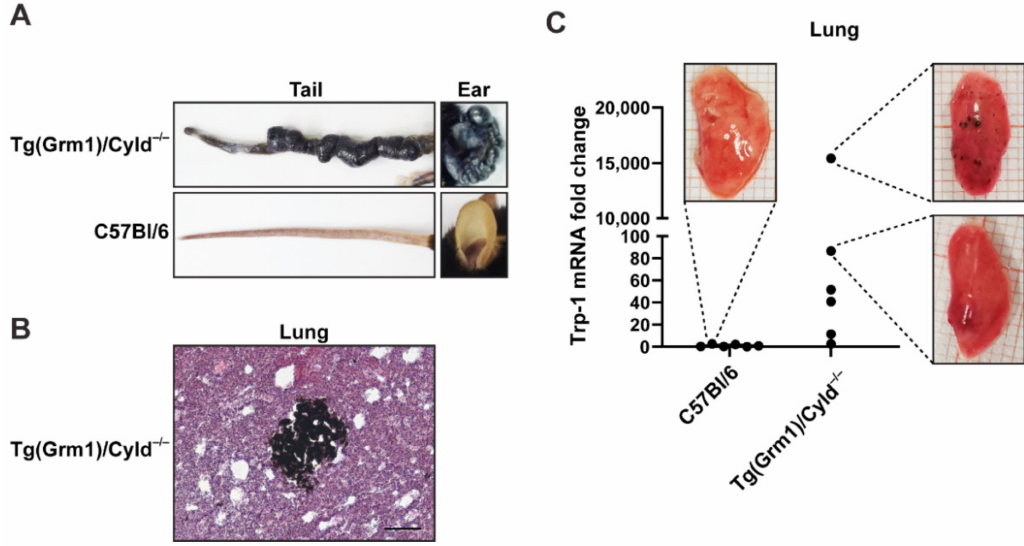
Figure 3. Quantitative detection of melanoma micrometastases in Tg( Grm1 )/ Cyld − / − transgenic mice. ( A ) Representative picture of melanomas detected on the tail and ear of 1-year-old C57Bl/6;Tg( Grm1 )/ Cyld − / − transgenic mice compared to C57Bl/6 control. ( B ) Hematoxylin/eosin (HE) staining of lung tissue from a C57Bl/6;Tg( Grm1 )/ Cyld − / − mouse con- taining a melanotic micrometastatic nodule. Scale bar, 500 µ m. ( C ) qRT-PCR analysis of Trp-1 expression in lungs from C57Bl/6;Tg( Grm1 )/ Cyld − / − mice in comparison to C57Bl/6 controls. Data were normalized to RPLP0 and to the mean Trp1-1 signal in the C57Bl/6 controls; n = 6. The images show lung lobe L1 for the indicated data